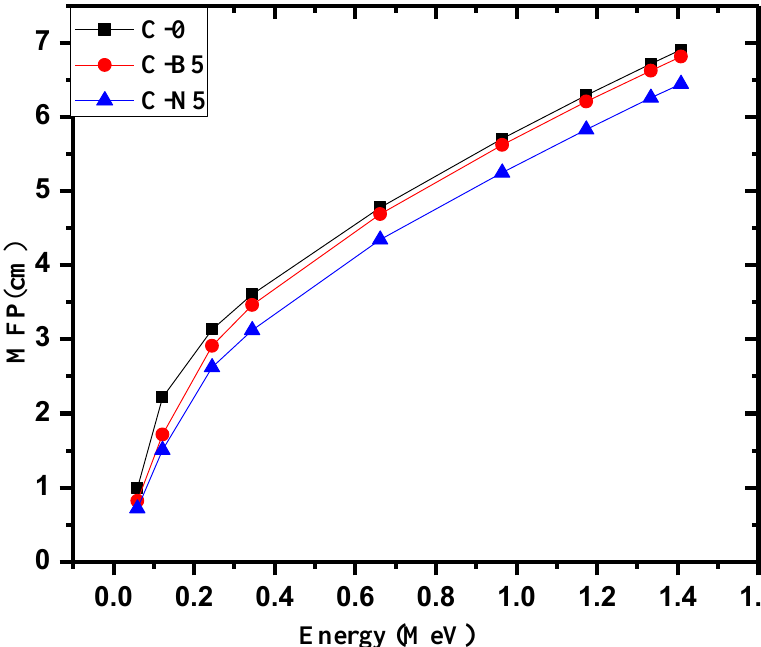
Figure 7. The mean free path for the C-0, C-B5 andC-N5. Figure 8 graphs the tenth-value layer (TVL) at 0.0595 and 0.1278 MeV for C-0, C-B5, and C-N5. At both 0.0595 and 0.1278 MeV, the TVL follows the order of C-0 > C-B5 > C- N5. More specifically, at 0.0595 MeV, they are equal to 2.27, 1.88, and 1.66 cm for C-0, C- B5, C-N5, respectively, and at 0.1278 MeV, they are equal to 4.96, 4.42, and 3.47 cm for the